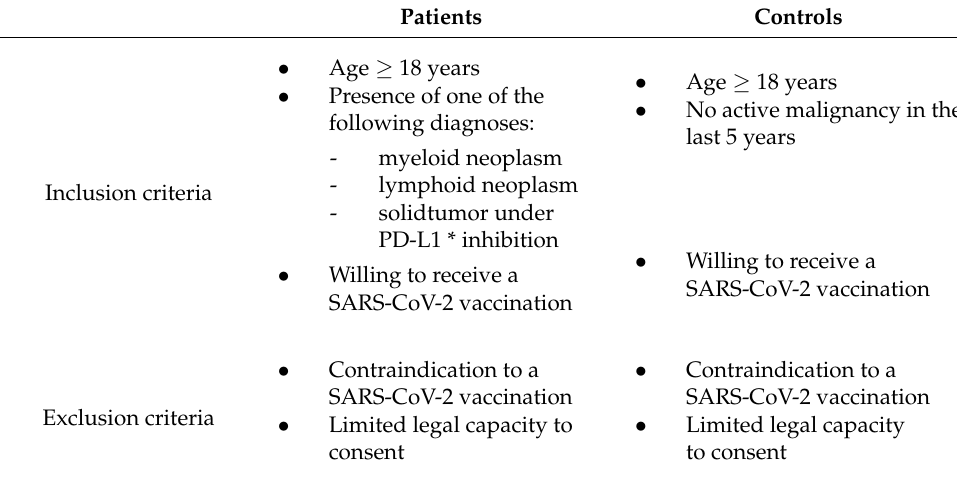
Table 1. Inclusion and exclusion